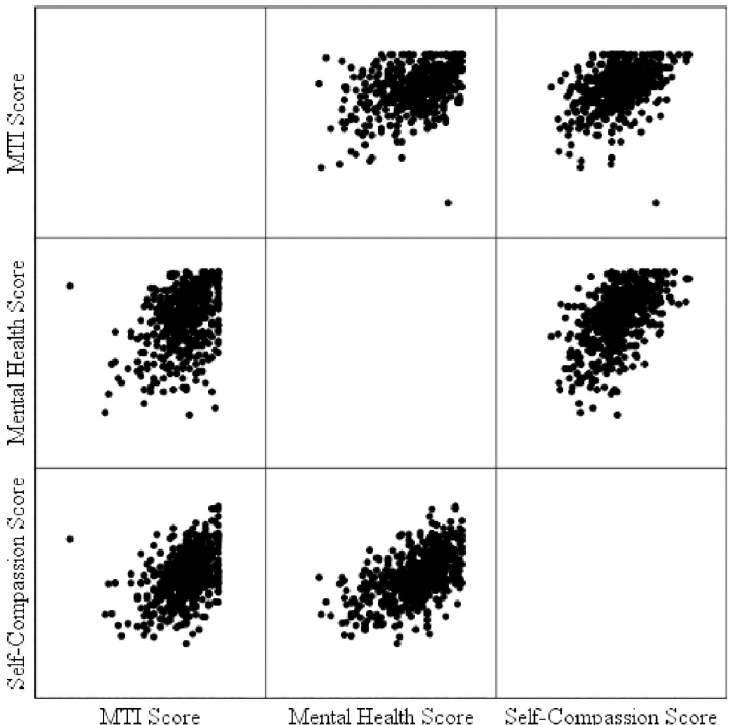
Fig 1. Scatterplot matrix of MT, SC, and MH